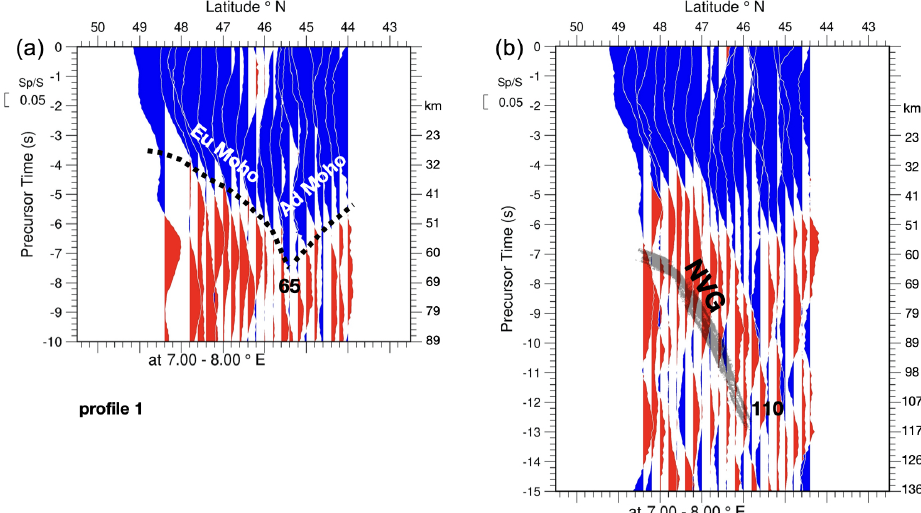
Figure 3. Profile 1. North–south profiles between 7–8 ◦ E. Differential times of converted waves relative to the S arrival times are given on the left of sections (a) and (b) . These times are converted into depth displayed on the right side of the sections using the global IASP91 velocity model. Blue colours indicate velocity increases with increasing depth (positive amplitudes), and red colours indicate velocity decreases (negative amplitudes). Note the vertical exaggeration of around 8.8 times. (a) Section of summation traces within bins of S-to-P piercing points at 50km depth, appropriate for imaging the Moho. Bin size along the profile is 0.2 ◦ ; the bin size perpendicular to the profile is given at the bottom of the section. The onsets of the S-to-P converted signals at the Moho are approximated by a dotted black line. “Eu Moho” refers to the European Moho, and “Ad Moho” designates the Adriatic Moho. The number given along the dotted black line in (a) indicates the greatest depth of the trough formed by the Moho signals. Panel (b) is the same as (a) but configured for a piercing point depth of 100km, appropriate for imaging the mantle lithosphere below the Moho. A concentration of negative (red) signals marked NVG (negative velocity gradient) is visible below the Moho. The base of the NVG appears more scattered than the Moho. Therefore, the arrival times are only approximately marked by a scattered grey line. Similarly, the number given at the bottom of the NVG in (b) approximately marks the deepest extent of the NVG. Legends of the following figures with profiles refer to this figure.